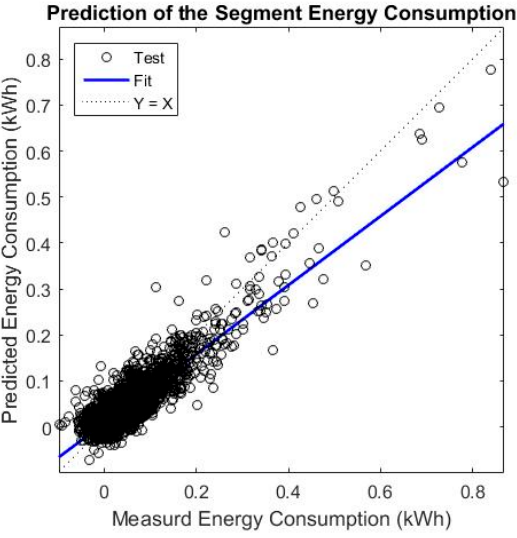
Figure 9. Regression plot for the NN–MLR prediction of the energy consumption on the segments in Dataset 2.